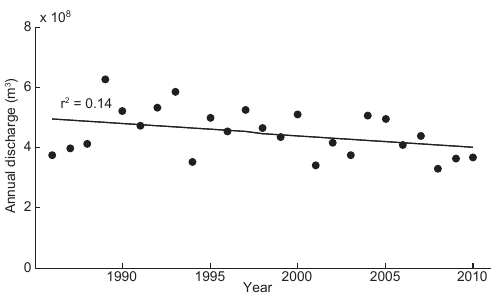
Fig. 6. Annual discharge between 1986 and 2010 at the outlet of Abiskojokken catchment. The discharge exhibits a significant ( p = 0 . 078) negative trend.